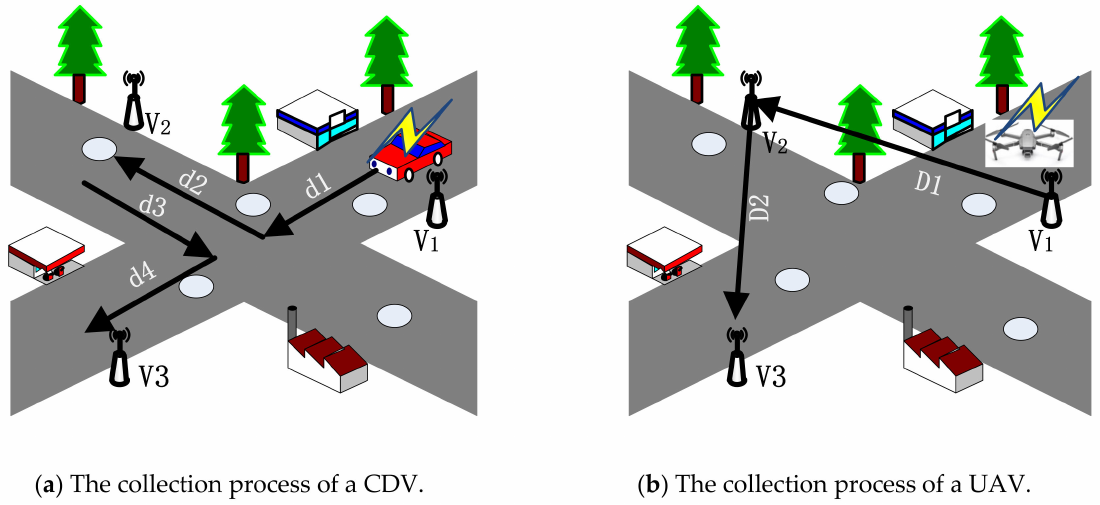
Figure 1. The difference in data collection performance between a CDV and the